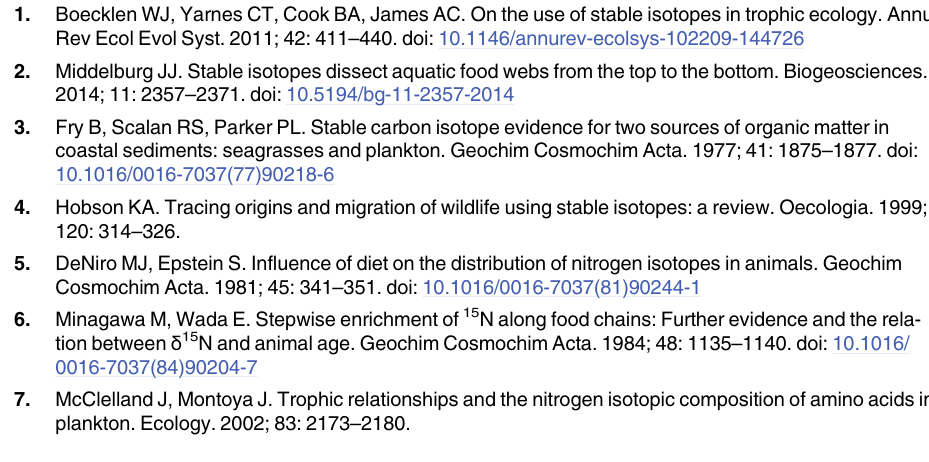
S1 Table. Stable nitrogen isotope values ( δ 15 N), C:N ratios, and lipid content of bulk and residual biomass, and total lipid extracts of samples used in this study. Samples highlighted in yellow indicate those used for amino acid analysis. S2 Table. Fatty acid composition, indicated by number of carbons and degree of unsatura- tion, of most abundant intact polar lipids (IPLs) in different aquatic species in this